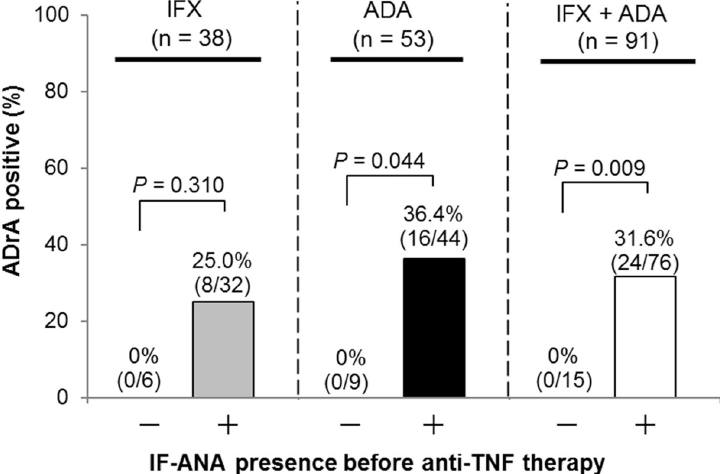
Fig 2. ADrA did not appear in the patients negative for IF-ANA before starting anti-TNF therapy. The rate of ADrA positive between 0–52 weeks was compared by IF-ANA presence or absence before anti-TNF therapy. The percentages and absolute numbers of each group of patients are indicated just above the bar graphs. Fisher’s exact test was used for comparison. ADrA, anti-drug antibodies; IFX, infliximab; ADA, adalimumab.